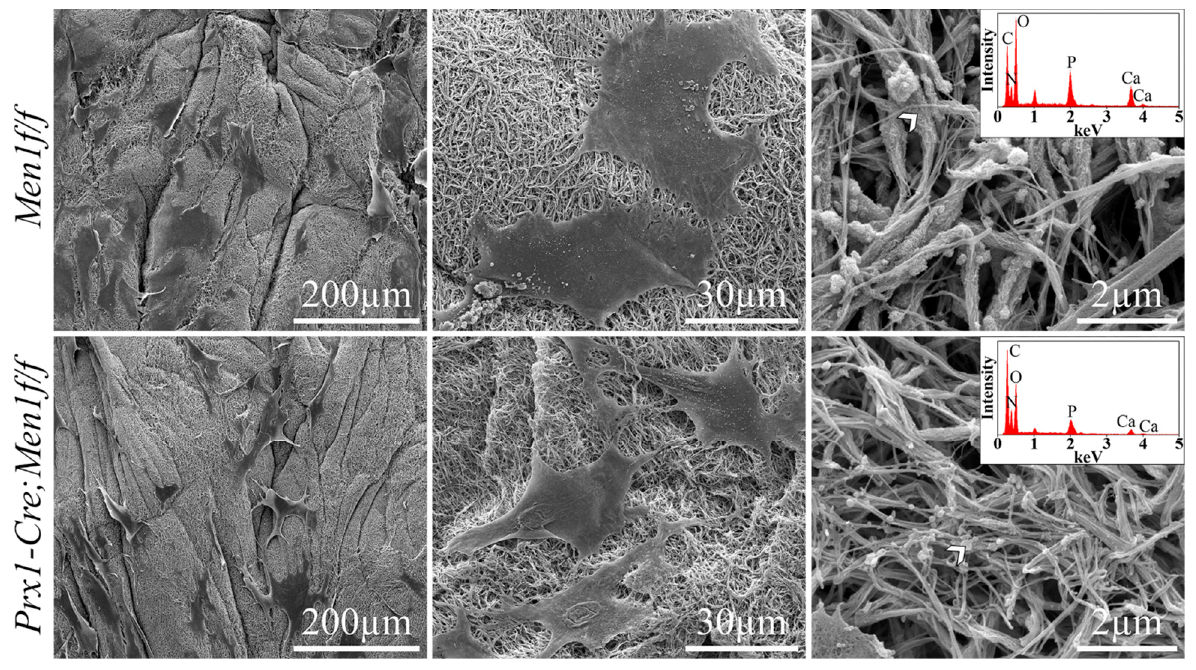
Figure 2. SEM micrographs at day 21 of calvarial osteoblasts from 6 month old Men1f/f and Prx1 ‐ Cre , Men1f/f mice 3D seeded in 3D dense collagen gels under osteogenic medium in vitro. Lower magnification SEM micrographs (left panel) depicted evenly distributed cells within the collagen gels in both groups. Higher magnification images qualitatively indicated that the morphology of Men1f/f cells appeared larger compared to that of Prx1 ‐ Cre, Men1f/f cells (middle panel). While mineralized particles were detected in both groups, mineralized collagen fibrils were only indicated in Men1f/f seeded gels (right panel). EDS revealed the presence of calcium and phosphorous in both groups (inset in right panel) ( n = 3) .